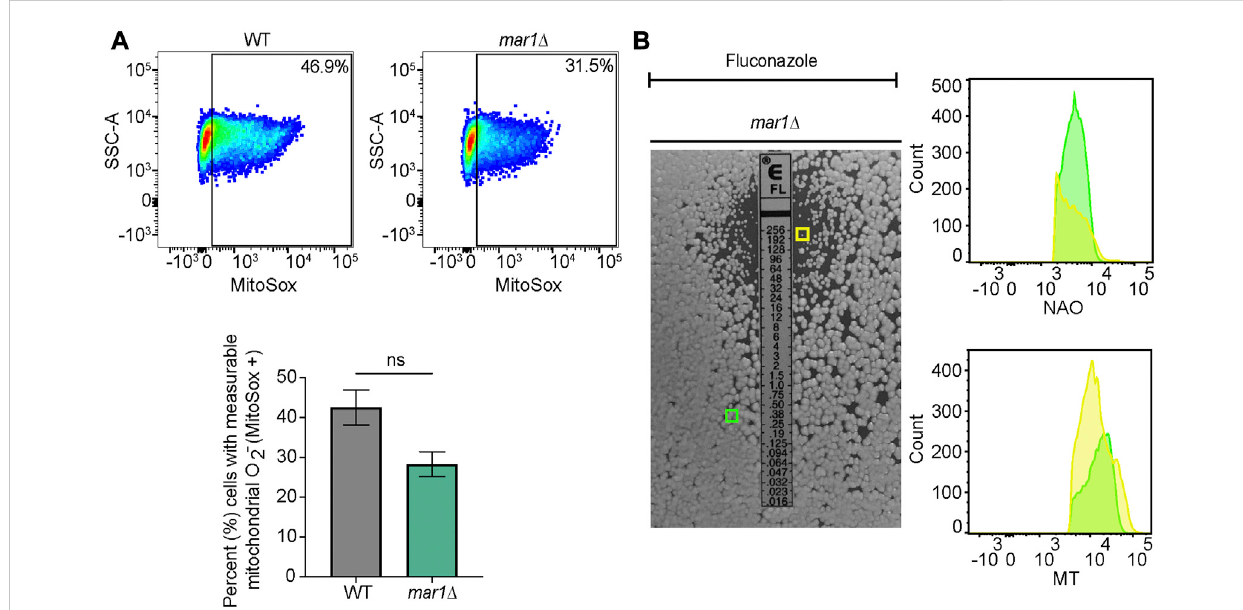
FIGURE 9 Mitochondrial phenotypes associated with fl uconazole tolerance. (A) Mitochondrial superoxide was measured for the WT strain and the mar1 Δ mutant strain following incubation in the presence of fl uconazole (10 μ g/mL). Cells were stained with MitoSox Red as a marker for mitochondrial superoxide. Flow cytometry was used to quantify staining intensity. Relevant events were gated for live cells (FSC vs. SSC), single cells (FSC-H vs. FSC-A), and positive labelling (SSC vs. MitoSox Red, determined using unstained cells as negative controls). Data are represented as dot plots with mean fl uorescenceintensityonthex-axisandSSC-Aonthey-axis,withpercentagesofcellsdisplayingMitoSoxRedstainingincluded.Theaveragepercentage of cells displaying MitoSox Red staining across two biological replicates ( n = 2) is also included. Error bars represent the SEM. Statistical signi fi cance was determined using Student ’ s t test (ns, not signi fi cant). O 2 − , superoxide. (B) Mitochondrial mass and mitochondrial membrane potential of mar1 Δ mutant strain fl uconazole-tolerant and non-tolerant cells from the assay described in Figure 8 were measured. Tolerant (within the zone of inhibition) and non- tolerant (outside of the zone of inhibition) colonies were isolated and mitochondria were co-stained with nonyl acridine orange (NAO), as a marker of mitochondrialmass,MitoTracker TM RedCMXRos(MT),asamarkerofmitochondrialmembranepotential,andSytox TM Blue(SB).Flowcytometrywasused to quantify staining intensity. Relevant events were gated for live cells (FSC vs. SSC and SSC vs. SB), single cells (FSC-H vs. FSC-A), and positive labelling (SSC vs. NAO/MT, determined using unstained cells as negative controls). Data are represented as histograms with mean fl uorescence intensity on the x-axis and cell number of the y-axis. Experiment was repeated twice to ensure reproducibility. Colored boxes indicate colonies assessed in histograms (yellow box = mar1 Δ mutant strain colony isolated from inside the zone of inhibition; green box = mar1 Δ mutant strain colony isolated from outside the zone of